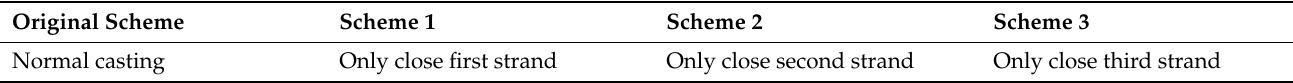
Table 2. Scheme of fewer strands casting.